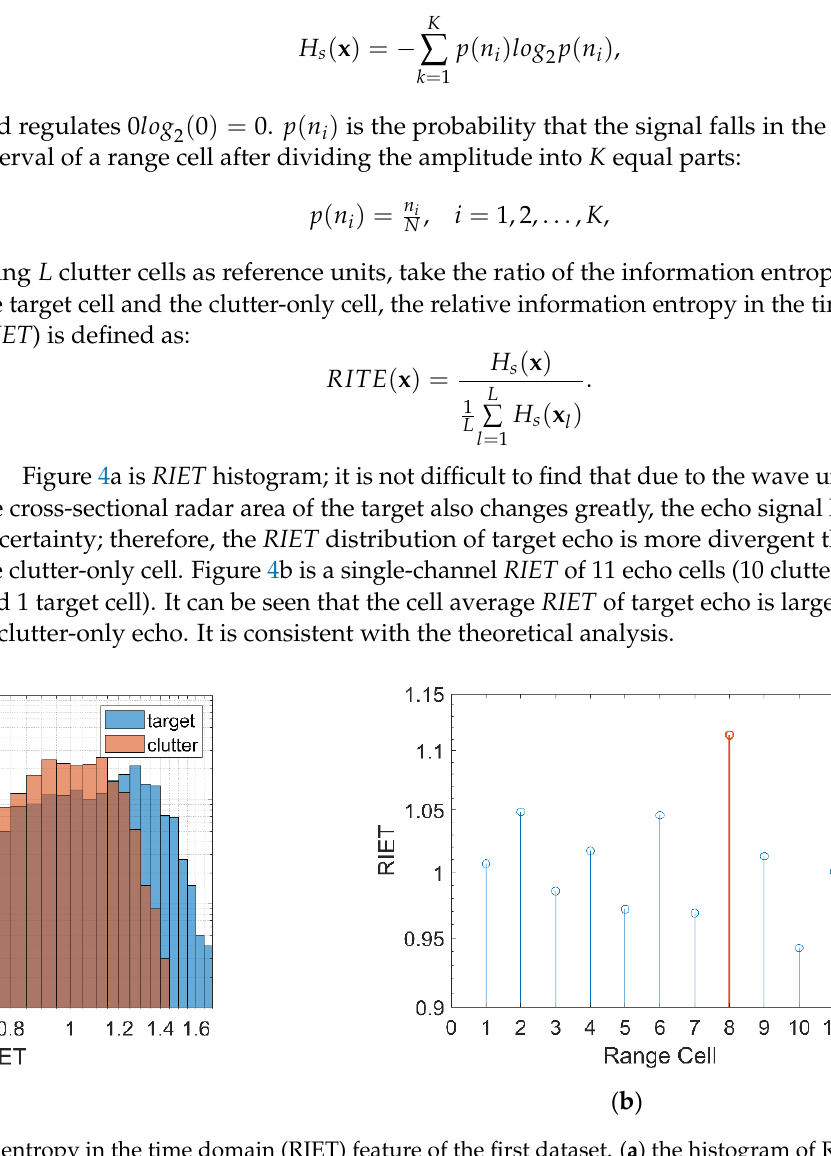
( b ) Figure 5. Frequency spectrogram of sea clutter and target signals from different echoes. ( a ) is the spectrogram of data names 19931107_135603_starea; ( b ) is the spectrogram of data names 19931111_163625_starea. The calculation process of RPH is introduced below. First, find the Doppler peak height of the echo signal and its corresponding frequency point.